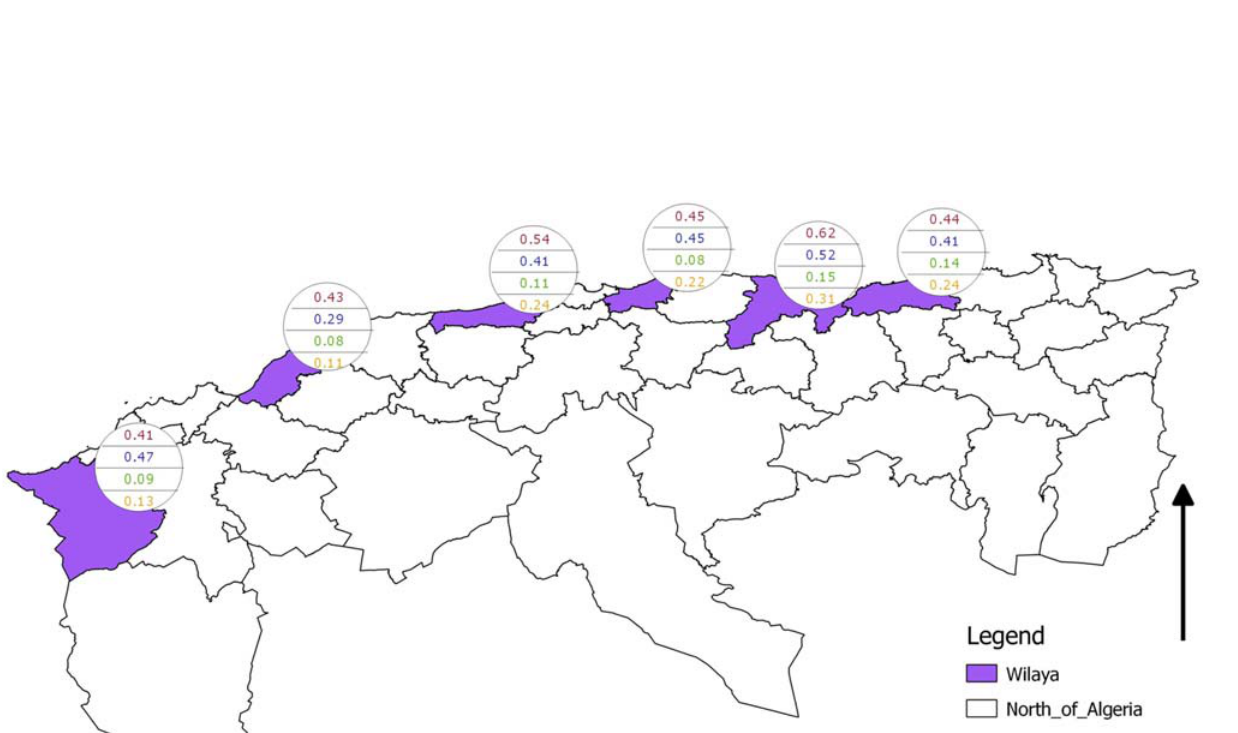
Fig 3. Apparent prevalence per locality. From top to bottom: only IFAT, only DAT, serial interpretation of the two test results and parallel interpretation of the two test results.